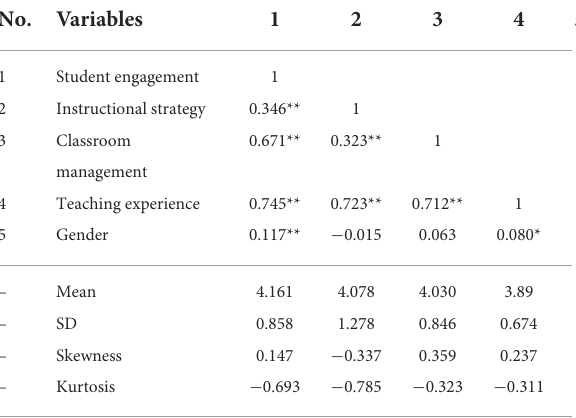
Table 2 presents the